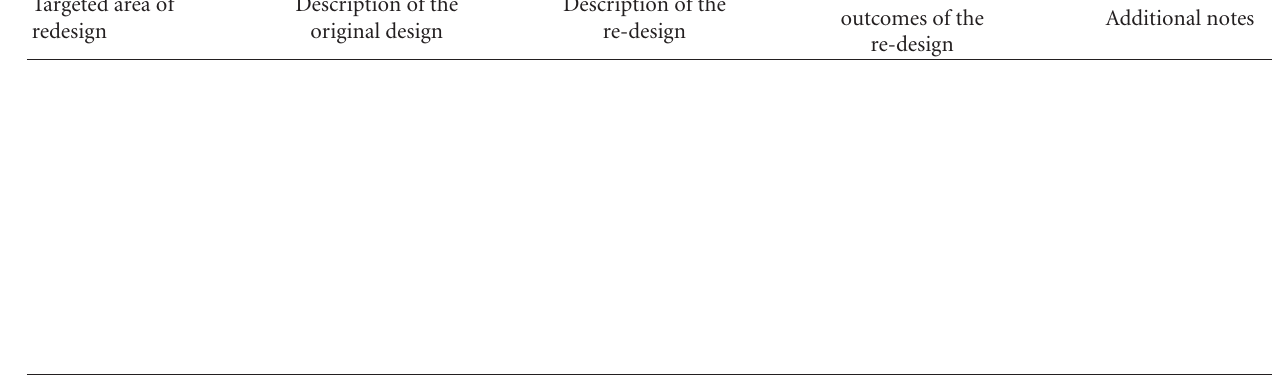
Table 2: Comparing and constructing the original design and the redesign of selected body system, organ, and/or part. Targeted area